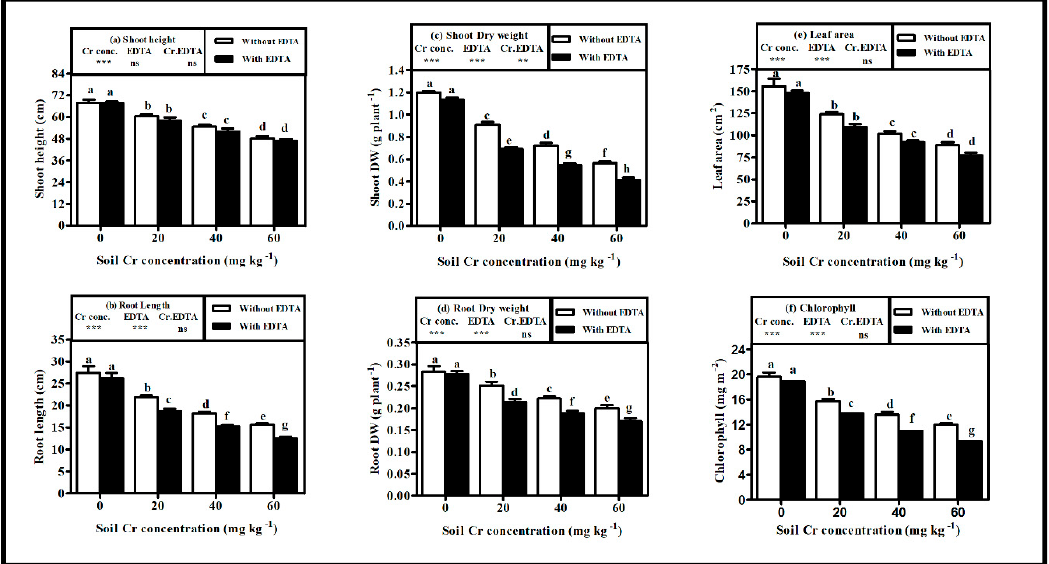
Figure 1. Influence of various Cr(VI) concentrations in soil on ( a ) shoot height, ( b ) root length, ( c ) shoot dry weight, ( d ) root dry weight, ( e ) leaf area, and ( f ) chlorophyll content of hybrid Napier grass with and without ethylene diamine tetra acetic acid (EDTA) application. Bars with dissimilar letters are significantly different at p < 0.05 from Tukey’s test. Values are means ± SE, n = 5. ** p < 0.001; *** p ≤ 0.001. ns: non-significant, Cr conc.: soil Cr(VI) concentration effect; EDTA: EDTA effect and Cr conc. EDTA: Cr(VI) conc. × EDTA interaction effect.